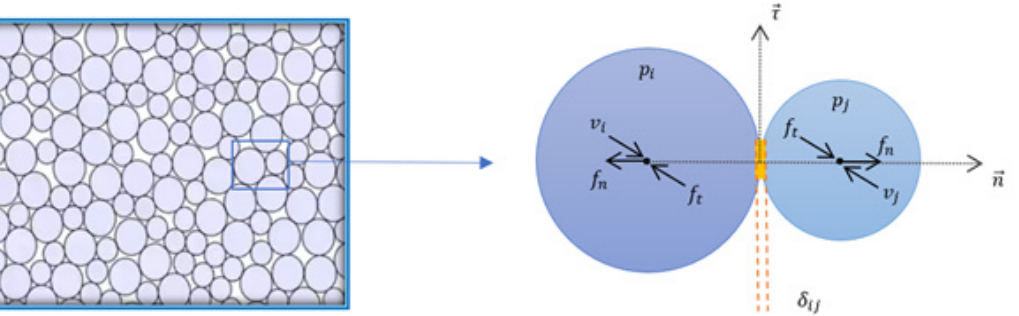
Figure 2. Schematization of the parameters associated with the contact mechanics between the particles. as shown in Figure 3.